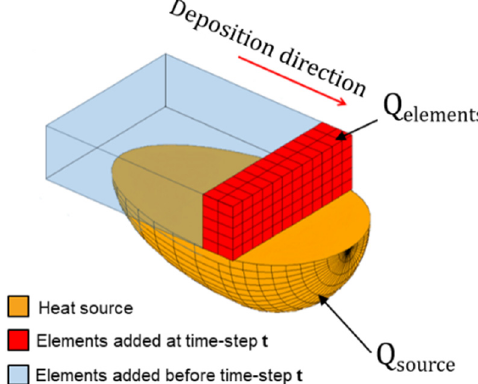
Fig. 1. Main steps of element deposition technique.